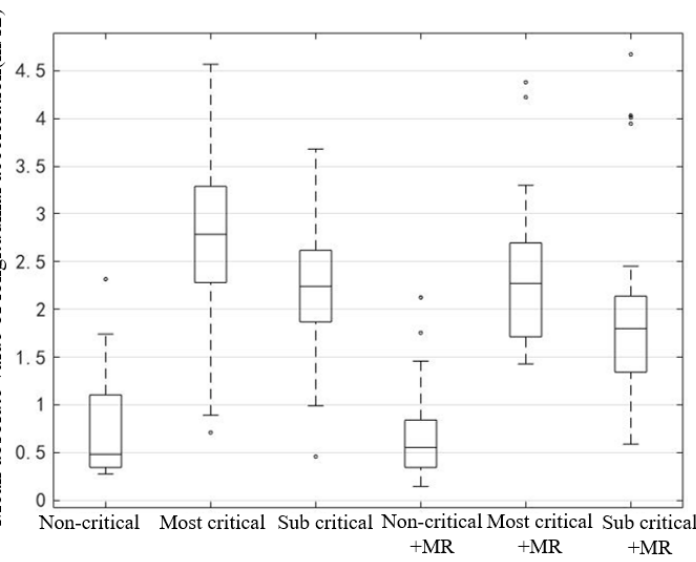
Figure 16. Box plot of the mean absolute value of longitudinal acceleration of the vehicle in 5 s after